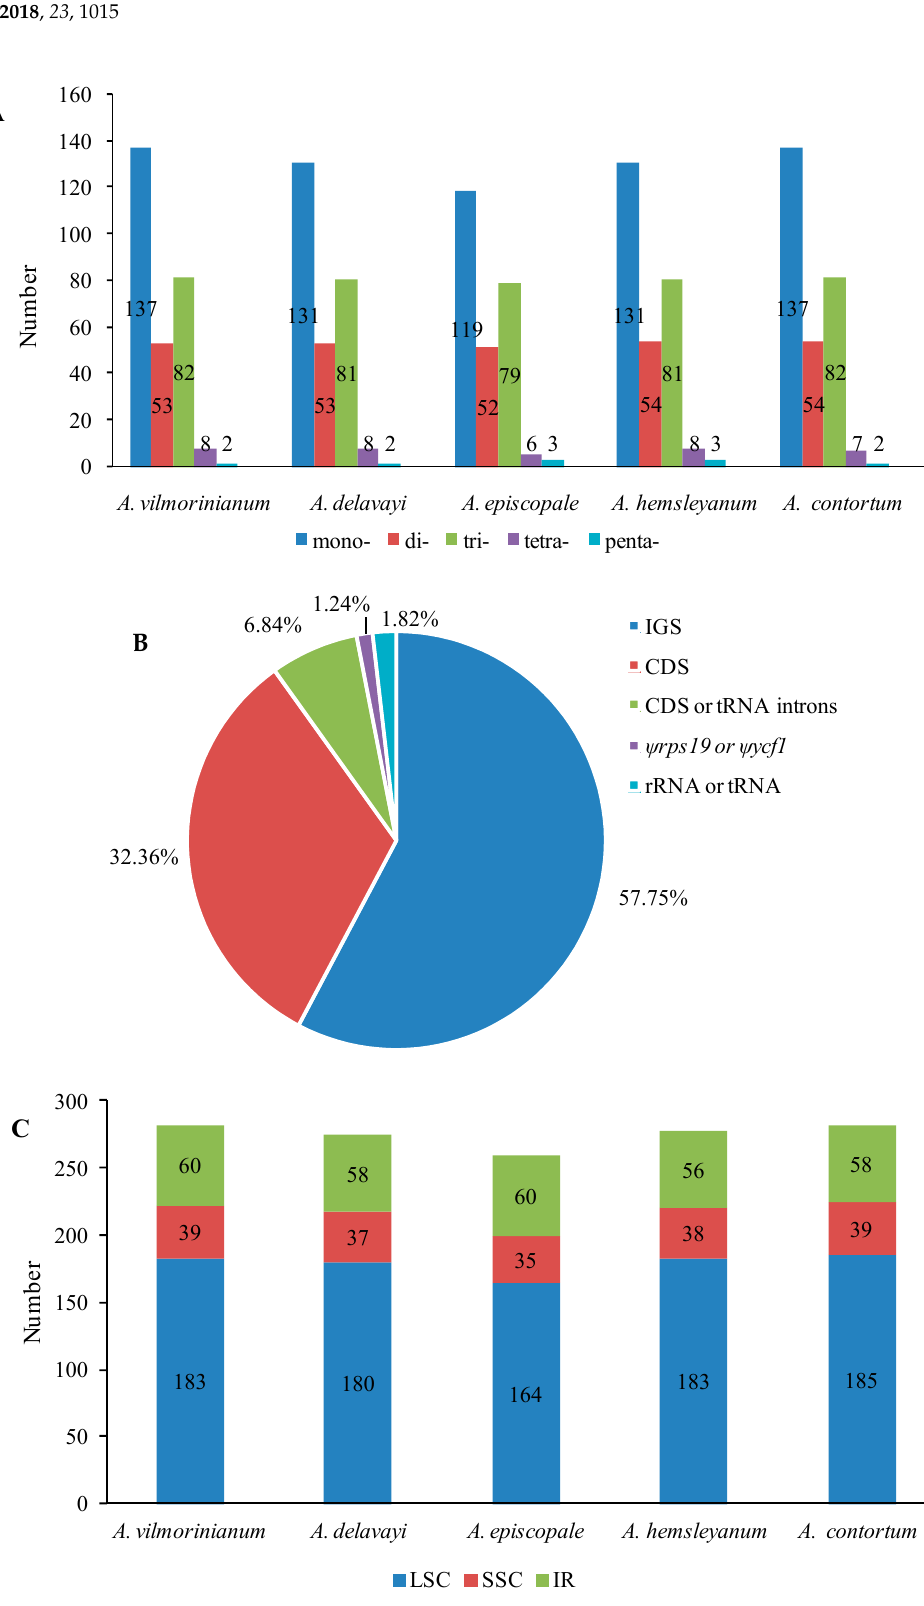
Figure 4. The number and distribution of SSRs in the chloroplast genomes of five Aconitum species. ( A ) Total number of repeats; ( B ) Proportion of repeats in IGS, CDS, CDS or tRNA introns, ψ rps19 or ψ ycf1 and rRNA or tRNA regions; ( C ) Number of repeats in LSC, SSC and IR.